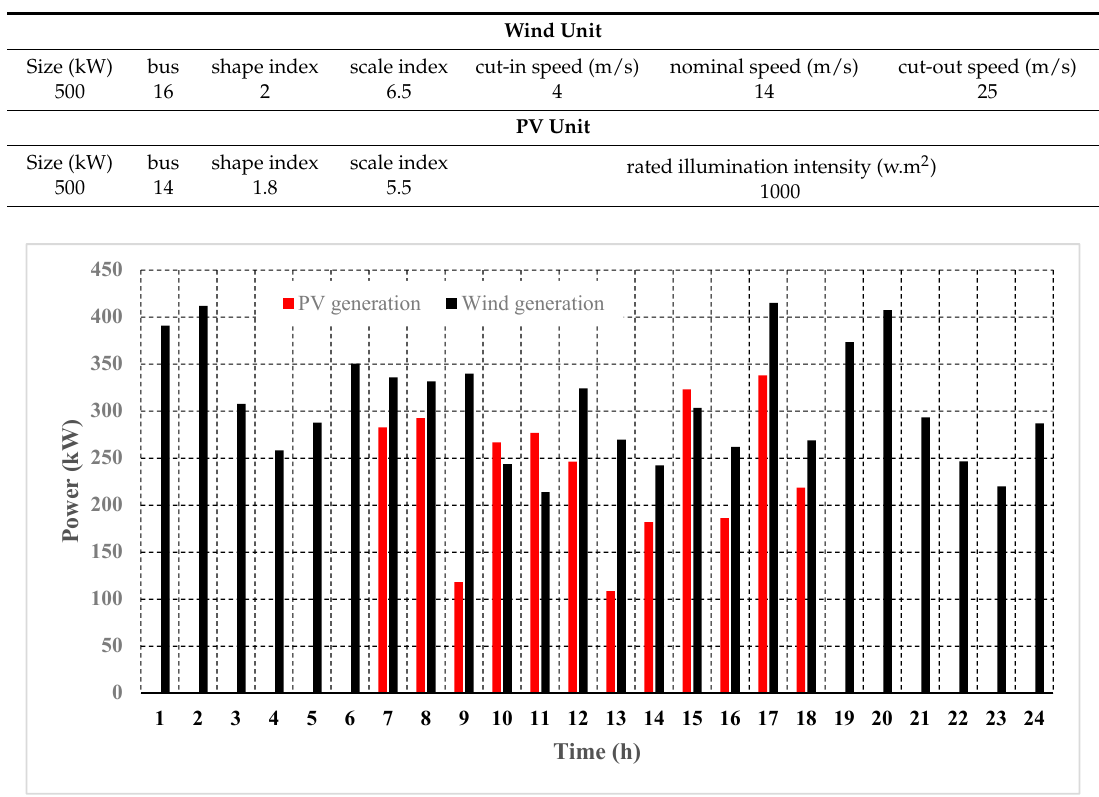
Table 1. Considered data for the PV and wind unit.